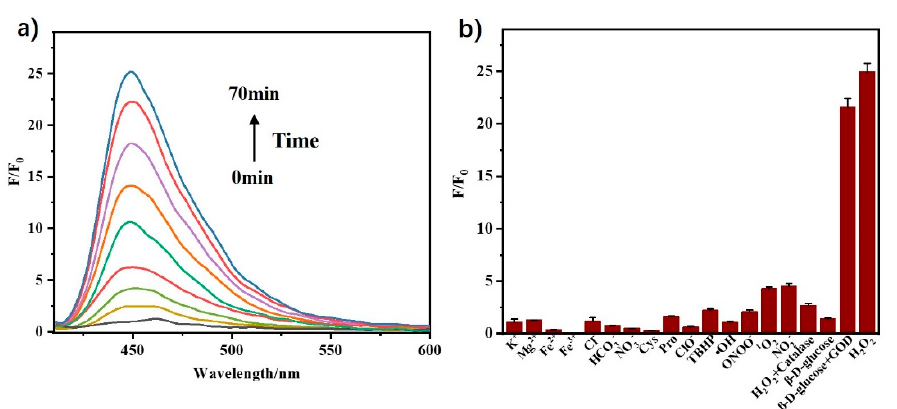
Figure 2. ( a ) The time response of the probe CMB . ( b ) Fluorescence response of CMB (2 µ M) to various competing species (100 µ M), including K + , Mg 2+ , Fe 2+ , Fe 3+ , Cl − , HCO 3 − , NO 3 − , cysteine (Cys), proline (Pro), hypochlorite (ClO − ), tert-butyl hydroperoxide (TBHP), hydroxyl radical (•OH), peroxynitrite (ONOO − ), singlet oxygen ( 1 O 2 ), nitrite (NO 2 − ), H 2 O 2 + catalase, β -D-glucose, β -D-glucose + glucose oxidase (GOD), and H 2 O 2 .